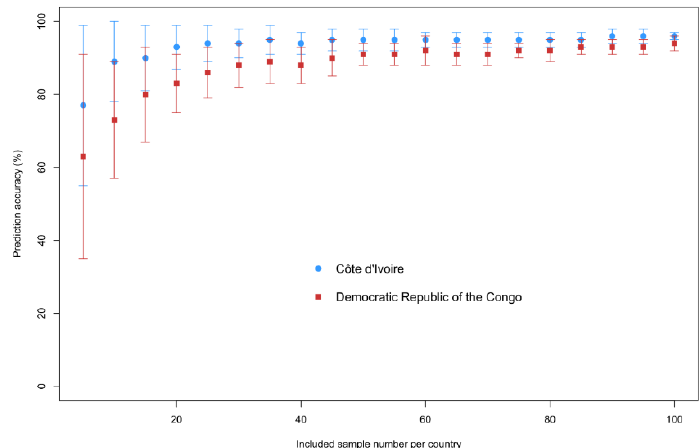
Figure 5. Prediction accuracy as a function of the number of samples for the provenancing of stem disks from Terminalia superba from Côte d’Ivoire and the Democratic Republic of the Congo through random forest analysis with five-fold cross-validation. The bars indicate the standard deviation per 100 runs.